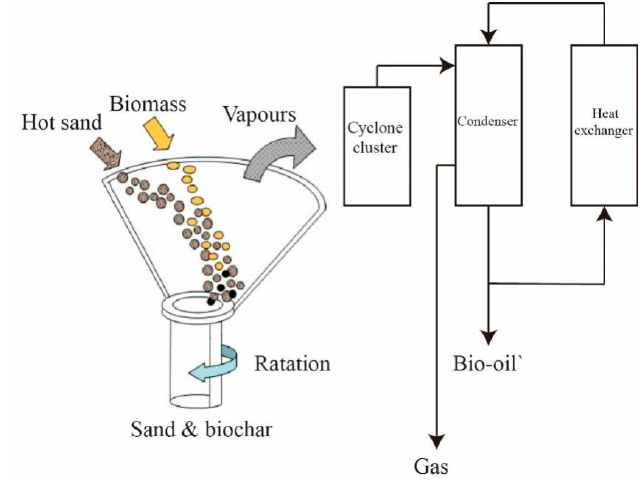
Figure 8. Schematic for the rotating cone reactor.